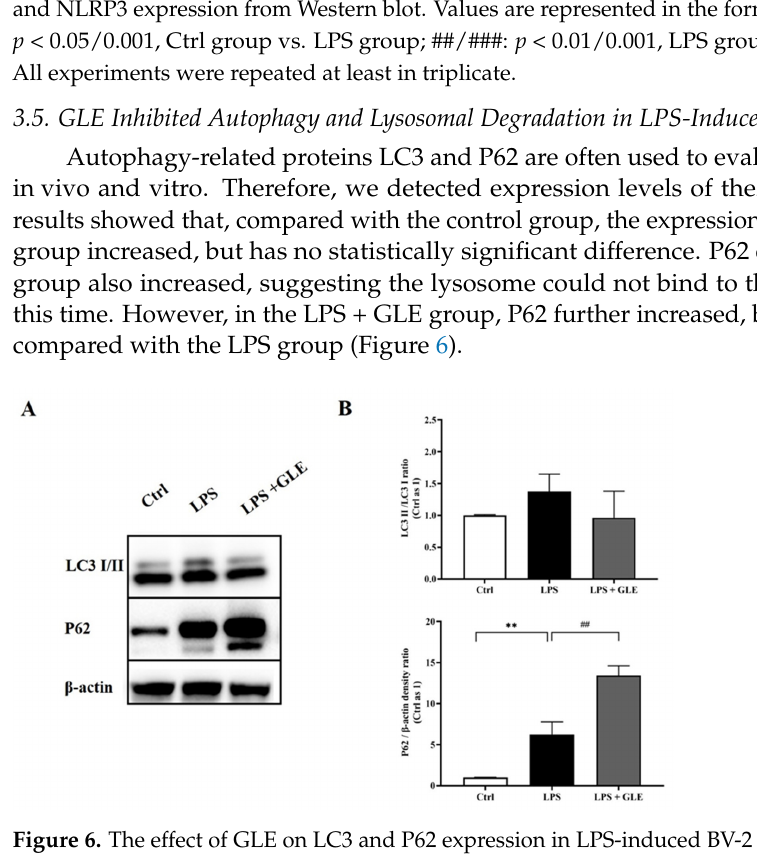
Figure 5. The effect of GLE on iNOS/NLRP3 expression in LPS-induced BV-2 cells. ( A ) Representative images of Western blot with antibodies against iNOS and NLRP3. ( B ) Quantification analysis of iNOS and NLRP3 expression from Western blot. Values are represented in the form of mean ± SEM. */***: p < 0.05/0.001, Ctrl group vs. LPS group; ##/###: p < 0.01/0.001, LPS group vs. LPS + GLE group. All experiments were repeated at least in triplicate.